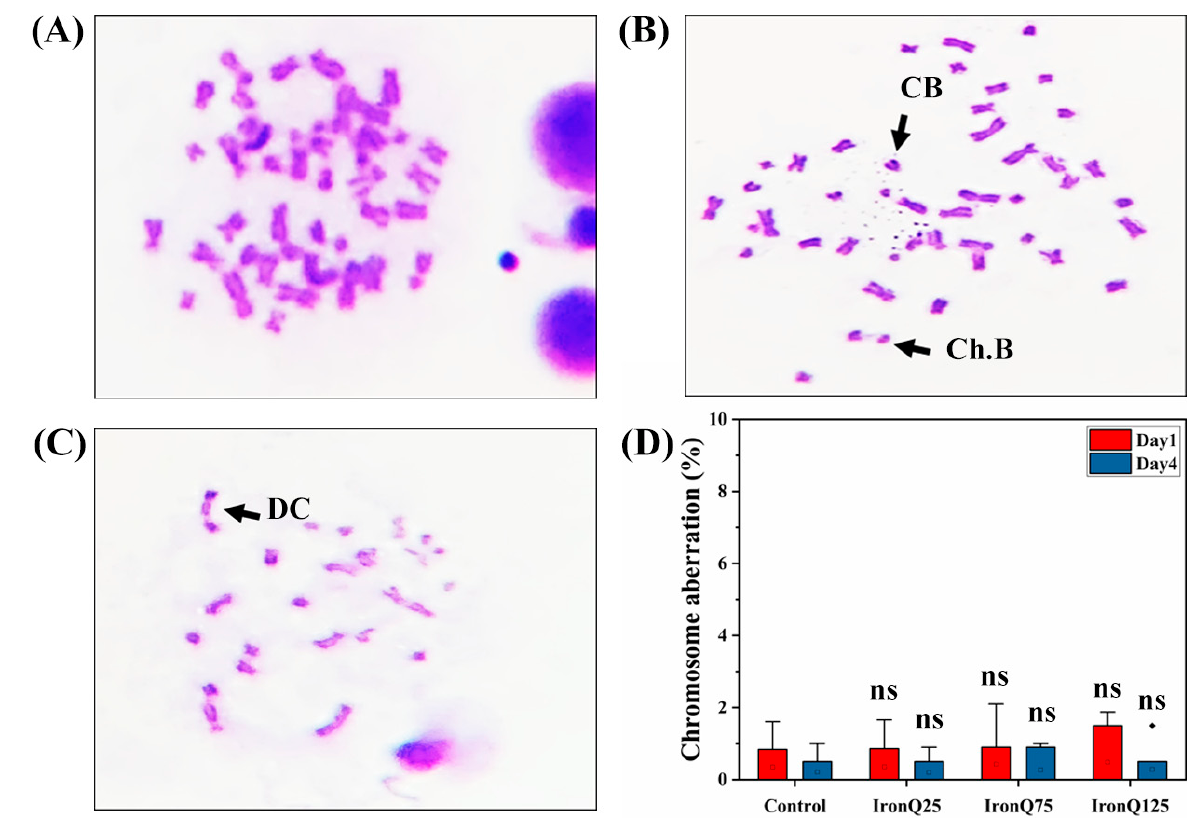
Figure 5. Genotoxicity assessment of PBMCs after labeling with IronQ by chromosomal aberration assay. Representative images showing different chromosome aberrations. ( A ) Normal metaphase chromosome. ( B ) Chromosome breaks and chromatid breaks. ( C ) Dicentric chromosome. ( D ) The graph shows that there was a non-significant increase in chromosomal aberrations on PBMCs labeled with different concentrations of IronQ. Data are expressed as mean ± SD of eight independent samples. ns indicates not significantly different from control. CB: chromatid breaks; Ch. B: chromosome breaks; DC; dicentric